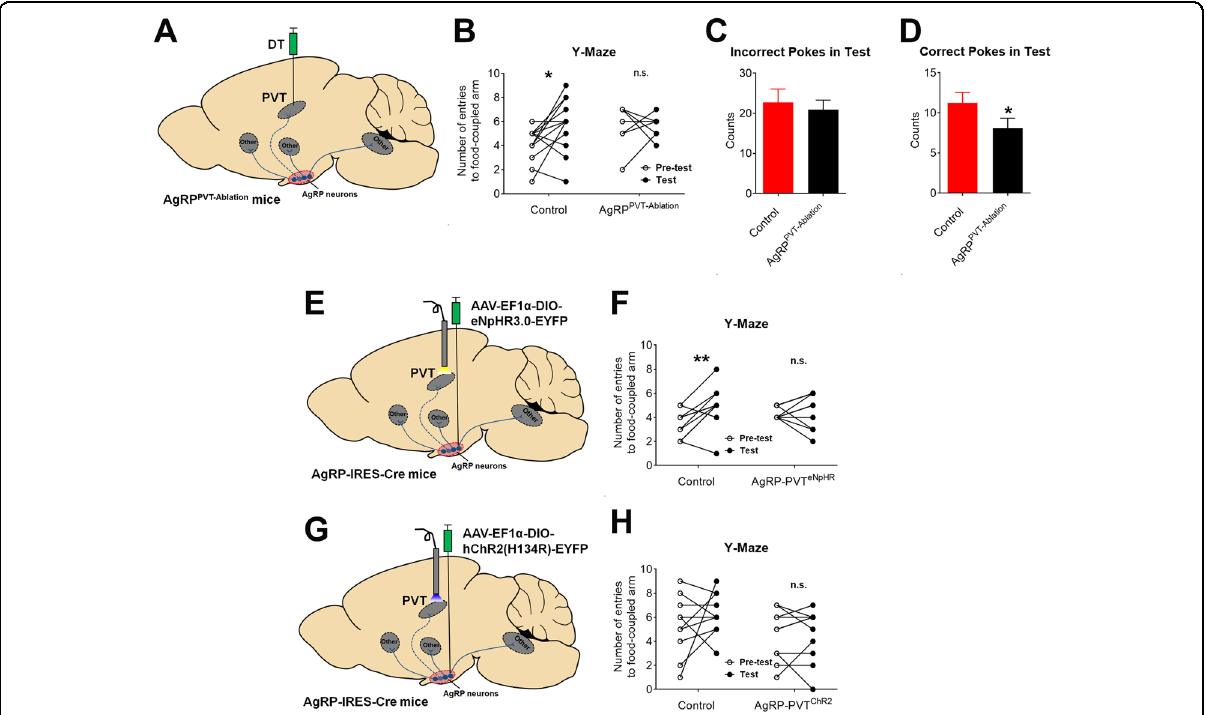
Fig. 6 The AgRP → PVT circuit regulates food seeking. A Schematic illustration to selectively ablate AgRP neurons projecting to the PVT. B Number of entries to food-coupled arm by control and AgRP PVT-Ablation mice during pre-test and the test in the Y-maze assay. n = 7 or 12 per group. * P < 0.05 between pre-test and the test in two-way ANOVA repeated measurement followed by post hoc Sidak tests. Note that the number of data points may appear fewer than the n values because multiple mice showed the same number of entries during the pre-test or the test. C , D Incorrect ( C ) and correct pokes ( D ) of control and AgRP PVT-Ablation mice in the food-baited hole board test. Data are mean± SEM. n = 12 or 15 per group. * P < 0.05 vs. control in one-tailed unpaired t tests. E Schematic illustration to selectively inhibit AgRP → PVT projections. F Number of entries to the food- coupled arm in the pre-test and the test in the Y-maze assay by control mice and mice with inhibited AgRP → PVT projections. n = 10 per group. * P < 0.05 between the pre-test and the test in two-way ANOVA repeated measurement followed by post hoc Sidak tests. Note that the number of data points may appear fewer than the n values in because multiple mice showed the same number of entries during the pre-test or the test. G Schematic illustration to selectively activate AgRP → PVT projections. H Number of entries to the food-coupled arm in the pre-test and the test in the Y-maze assay by control mice and mice with activated AgRP → PVT projections. n = 10 per group. Note that the number of data points may appear fewer than the n values in because multiple mice showed the same number of entries during the pre-test or the test. Also see Figs. S6,